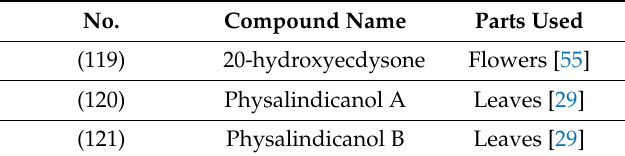
Table 5. Steroids from Brugmansia suaveolens .